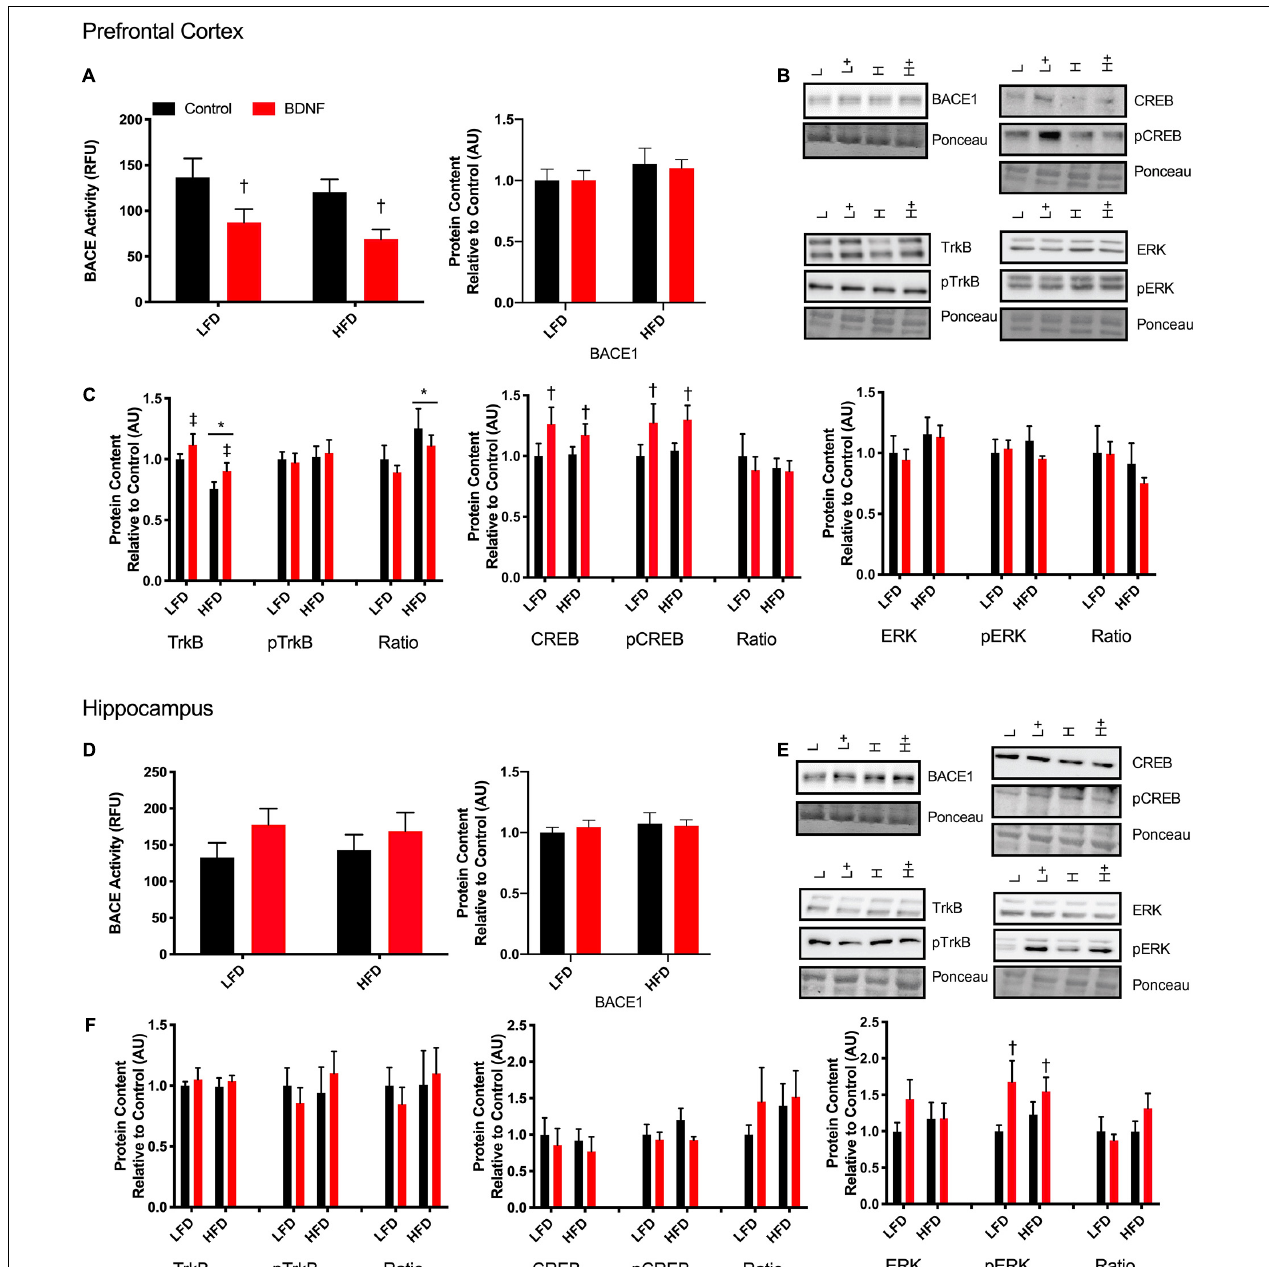
FIGURE 4 | Explant study. (A) BDNF treatment reduces BACE activity in the prefrontal cortex from lean and obese mice, however, there were no changes in BACE1 content. (B) Representative immune blots for downstream markers of BDNF signaling in the prefrontal cortex. (C) BDNF treatment recovers HFD induced TrkB reduction and increases total and phosphorylated CREB in the prefrontal cortex. There were no detectable changes in ERK in the prefrontal cortex. (D) There were no detectable changes in BACE activity or content in the hippocampus with BDNF treatment. (E) Representative blots for downstream markers of BDNF signaling in the hippocampus. (F) There are no detectable changes in total or phosphorylated TrkB or CREB, however, BDNF treatment increased phosphorylated ERK content in the hippocampus. Values are represented as mean ± SEM. Significance indicated by * p < 0.05 compared to LFD, † p < 0.05 compared to sedentary, ‡ p = 0.058 compared to LFD. Western blots have been cropped to provide a representative